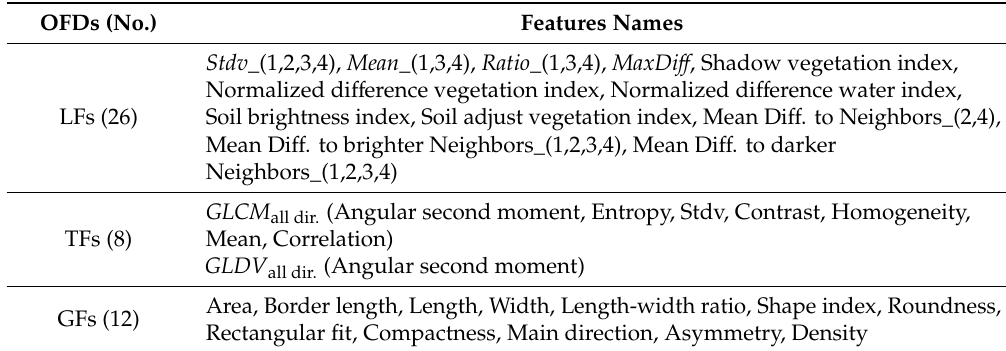
Table 4. Selected features employed in this